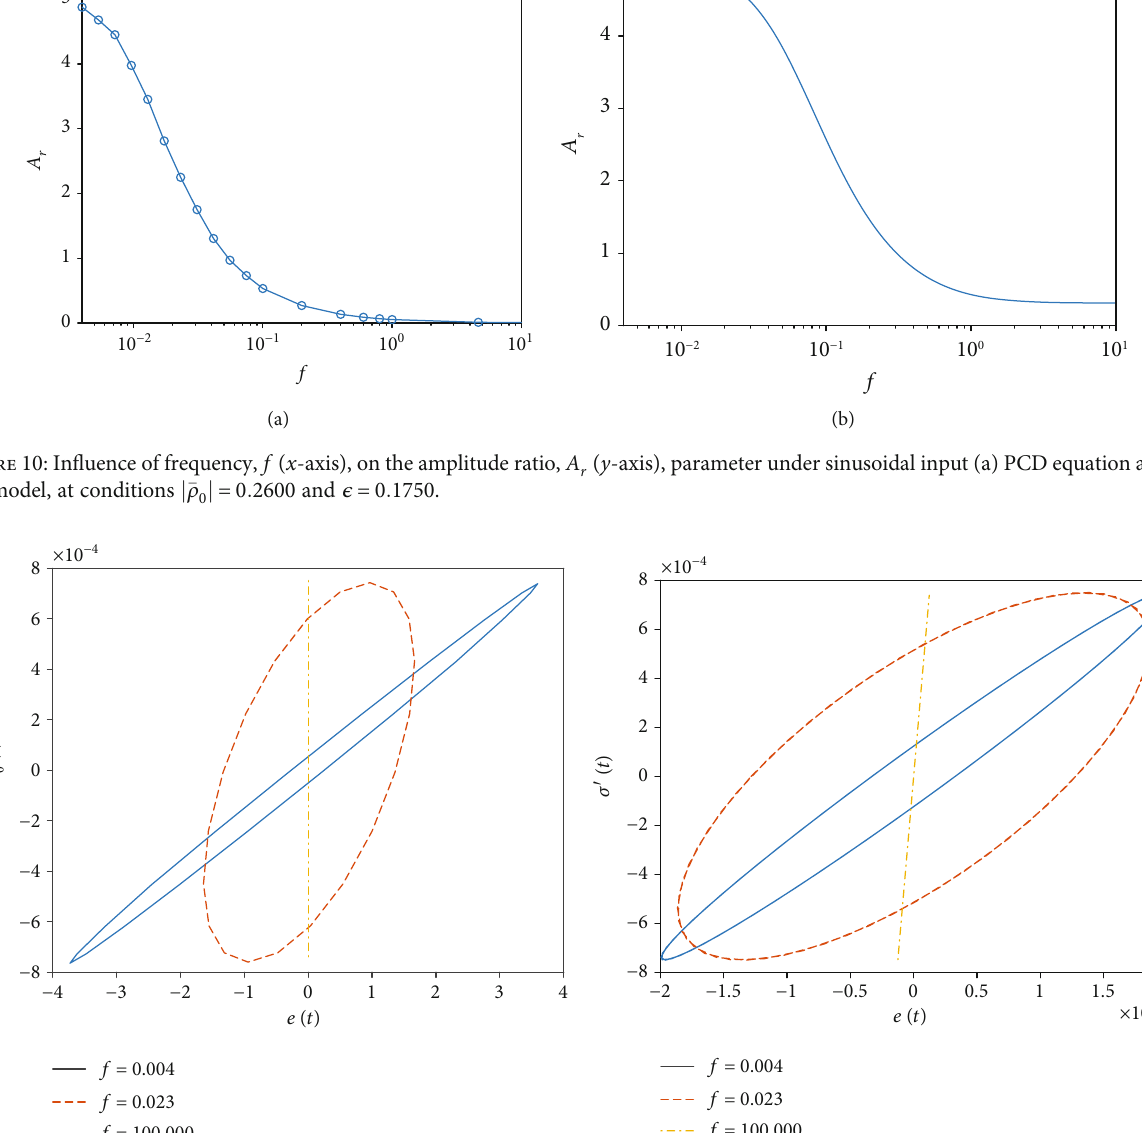
′ = 0 : 00075 , K = 0 : 3750 , A (cid:1) ð t Þ ( y -axis) and σ ′ ð t Þ ( y -axis) are the pressure input at time t P 0